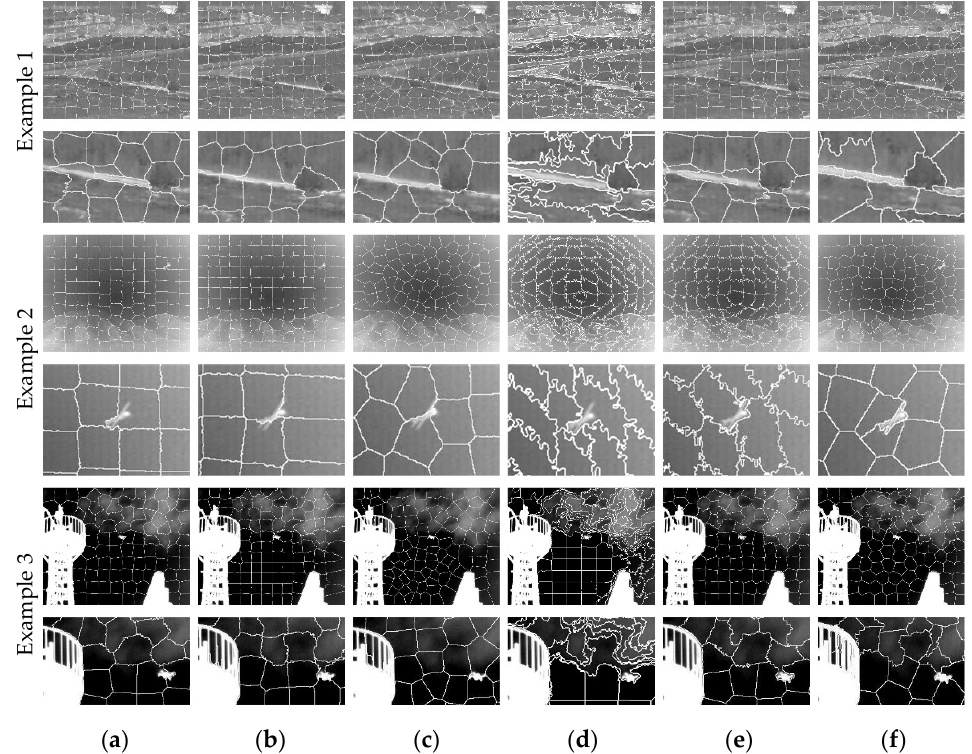
Figure 11. Experimental results of IR image superpixels in the self-built dataset from compared algorithms: ( a ) SLIC; ( b ) SNIC; ( c ) LRW; ( d ) USEAQ; ( e ) CAS; and ( f ) our method. The zoomed-in regions located below the results show that our method has better capability of adhering to boundaries.